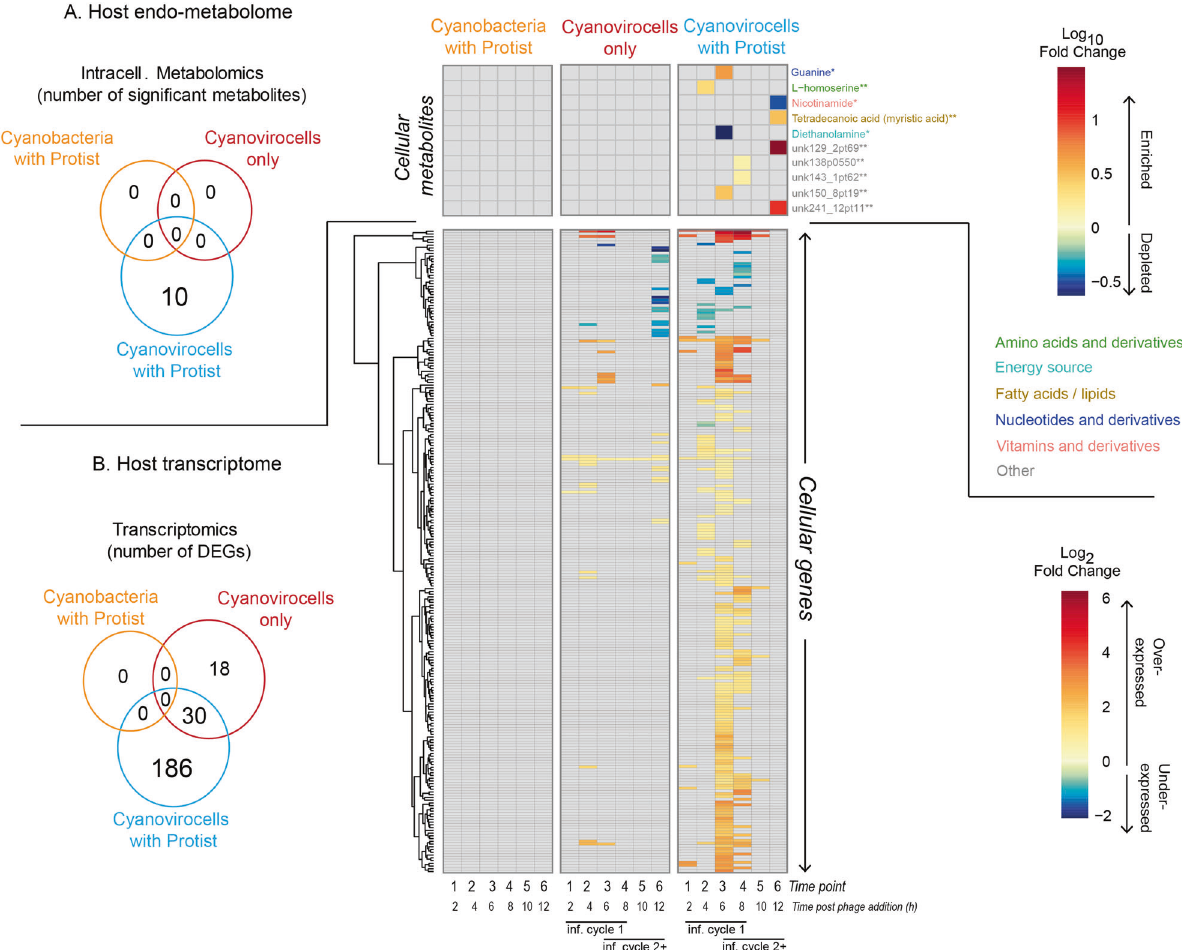
Fig. 3 Host genes and metabolites altered in each treatment relative to the untreated control. A Number of intracellular metabolites detected as signi fi cantly changing in each of the treatments (Venn diagram) and their log 10 FC value in the treatment relative to the untreated cells (heatmap). Compound names are colored by the class to which they belong, and the con fi dence in their detection is indicated by an asterisk next to the name. Con fi dence of level 1 (1 asterisk) indicates the compound had three identi fi cation criteria in positive or negative mode (i.e., retention peak, mz, and msms), whereas level 2 (2 asterisks) denotes two of the three criteria were met. Compounds denoted as “ Other ” represent detected features that were not identi fi ed. B Number of host genes differentially expressed in response to protist only ( “ cyanobacteria with protist ” ), phage only ( “ cyanovirocells only ” ), or phage plus protist ( “ cyanovirocells with protist ” ) pictured in a Venn diagram as well as their heatmap, which denotes gene expression as log 2 fold change (FC) values in the treatment compared to the untreated control over the experiment time course. Gray heatmap cells denote genes or metabolites that did not signi fi cantly change their expression or abundance, respectively, in the treatment relative to the control. All represented data derive from the average of a minimum of three biological replicates in which the treatment was compared to the uninfected control (cells only, no phage, no protist). The time course for the cyanovirocells and cyanovirocells with protist captures more than one infection cycle: the fi rst one with the phages added at the start of the experiment ( “ inf. cycle 1 ” ) and the ones that follow once the phages are released from “ inf. cycle 1 ” and infect new cells ( “ inf. cycle 2 + ”